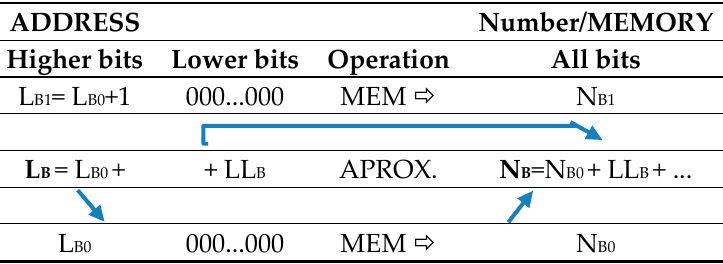
B using a simple bit